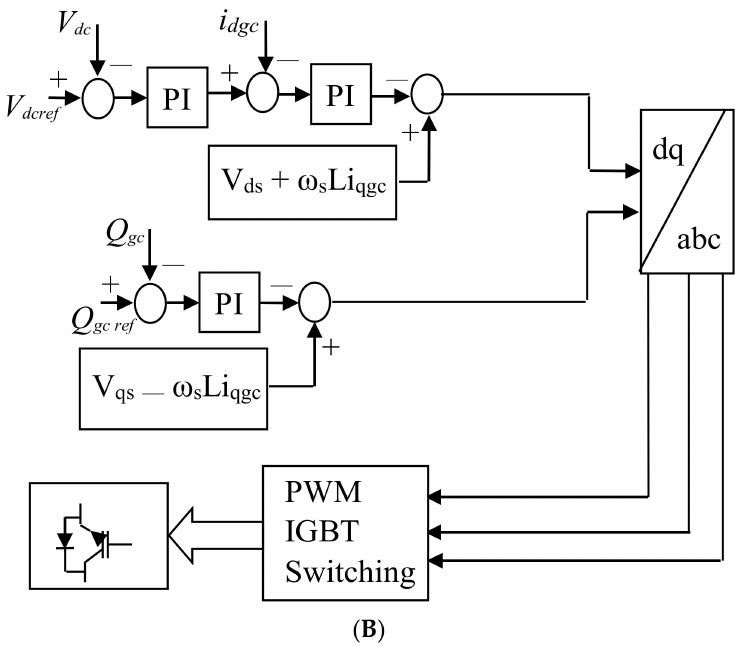
Figure 3. ( A ) The DFIG wind turbine RSC control. ( B ) The DFIG wind turbine GSC control.